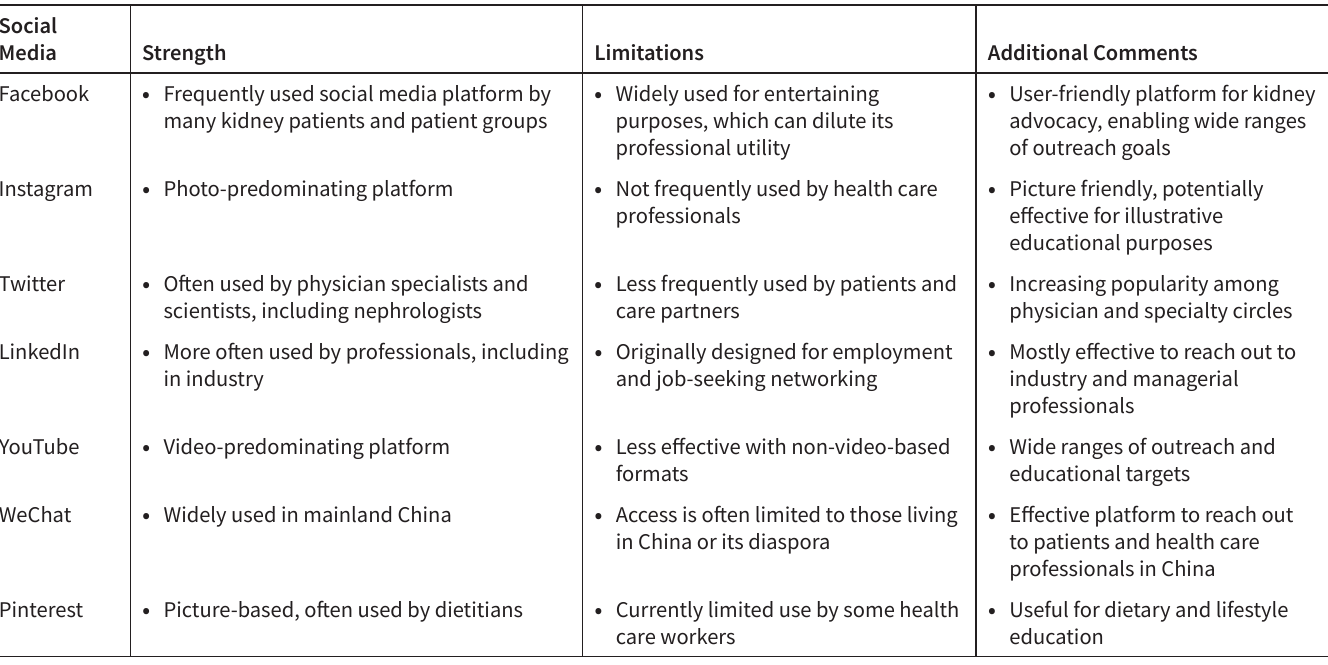
Table 2. Social Media That Are More Frequently Used for Kidney Education and